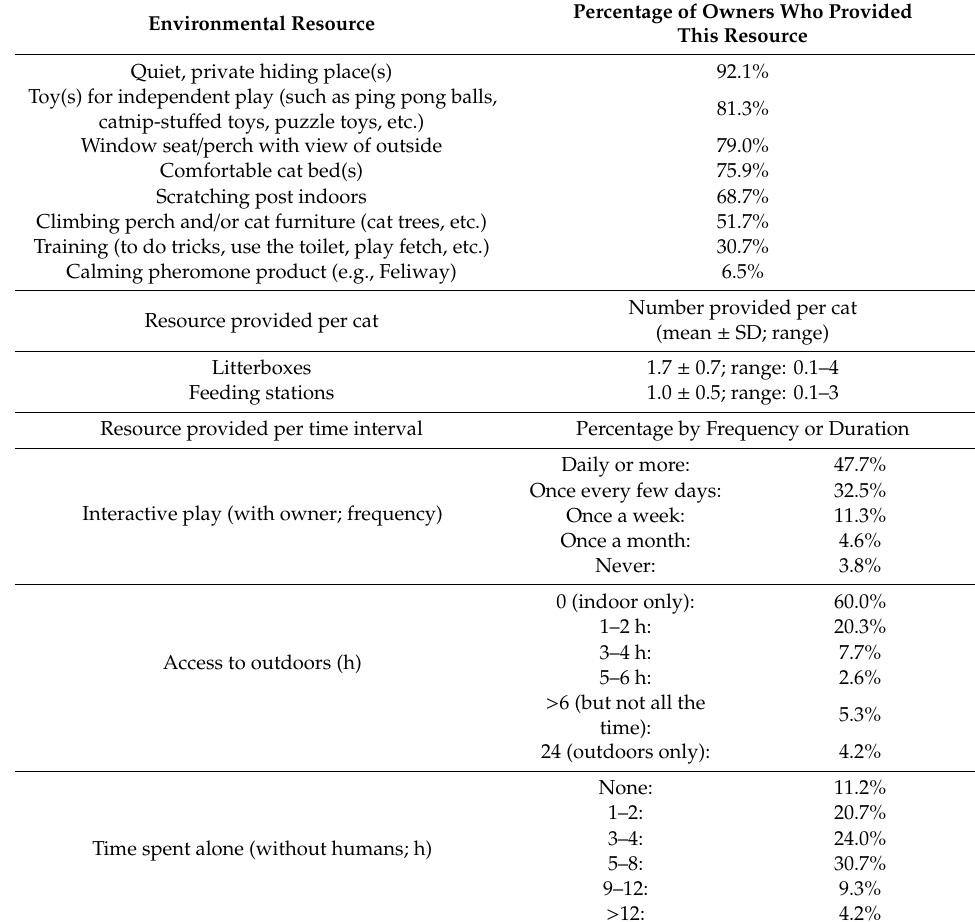
Table 2. Resources provided to companion cats living in homes ( n = 547 respondents). Environmental